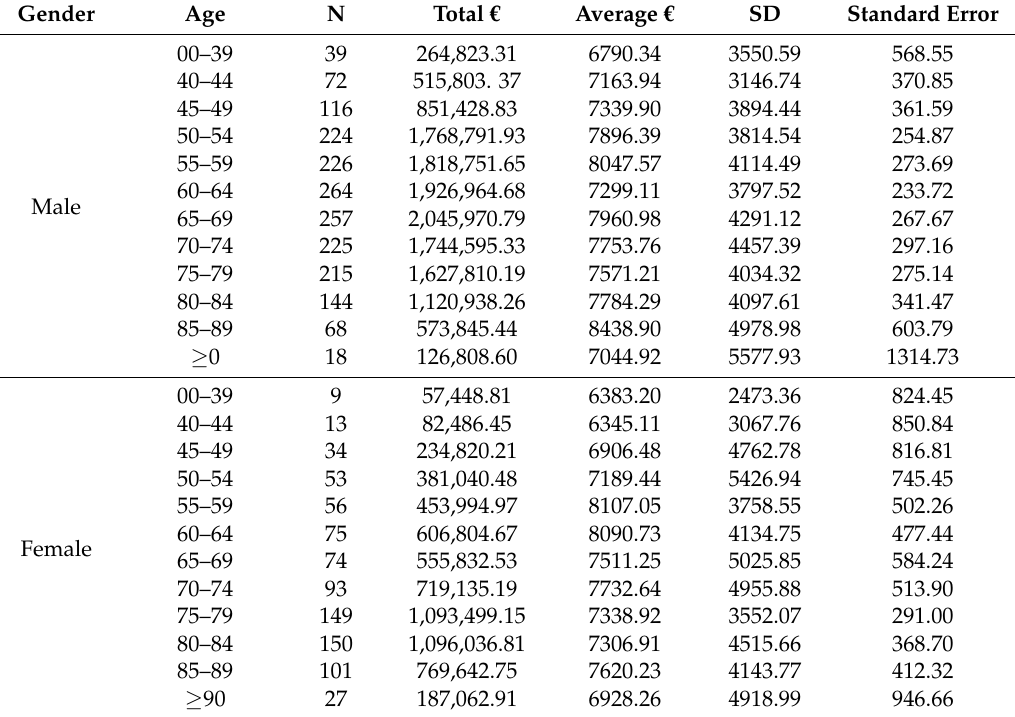
Table 4. Cost by sex and age